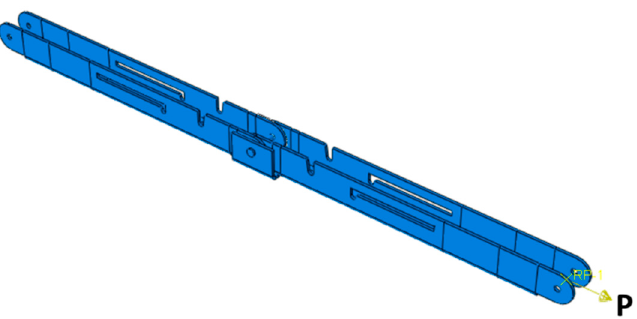
Figure 38. Uniaxial tension simulation of primary folding link bars for bearing and pin shear capacity.